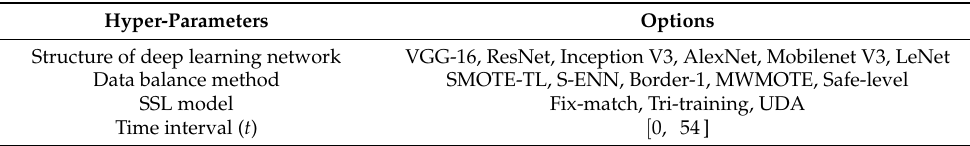
Table 5. Structural hyper-parameters for our monitor system.